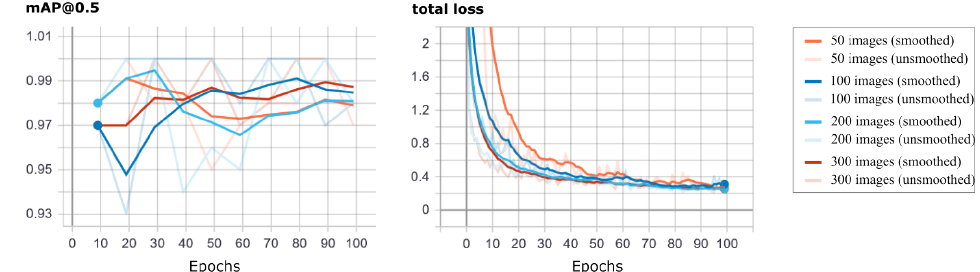
Figure 8. Comparison of different training dataset sizes. The Faster R-CNN model F + is trained for 100 epochs on subsets of the fruits dataset with 50, 100, 200, and 300 images. Shown are the mAP@0.5 (left column) and the value of the Faster R-CNN loss function (the total Faster R-CNN loss is a linear combination of four parts: the classification loss and the bounding box regression loss from both, the region proposal part and the Fast R-CNN layers) (right column) over time. As in Figure 6a, recall and precision are very similar to mAP@50; therefore, we did not include them here. The validation dataset is the same for all training runs. The shown graphics are exported from Tensorboard with a smoothing factor of 0.8 (dark lines), the unsmoothed values are included as light